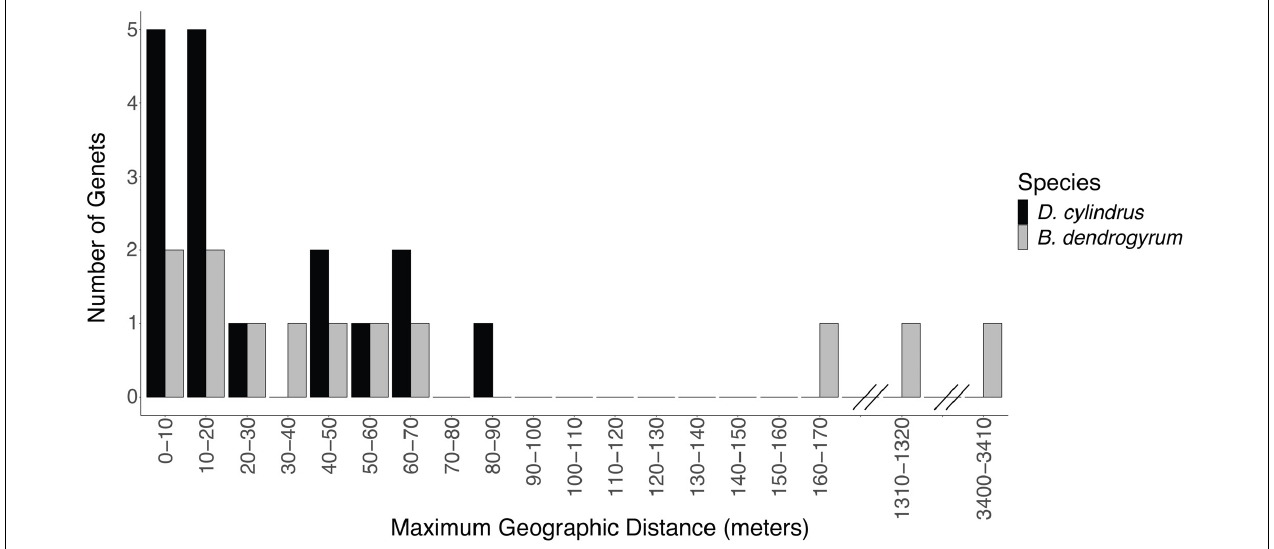
FIGURE 4 | The maximum geographic distance between ramets of the same genet of Dendrogyra cylindrus (black bars) and Breviolum dendrogyrum (gray bars). While no coral genets were shared between sites, symbiont strains were occasionally shared between sites. Note the discontinuous x -axis.